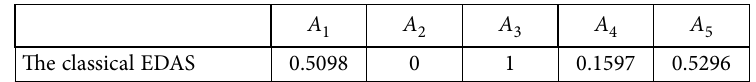
Table 6. The appraisal scores of classical EDAS method